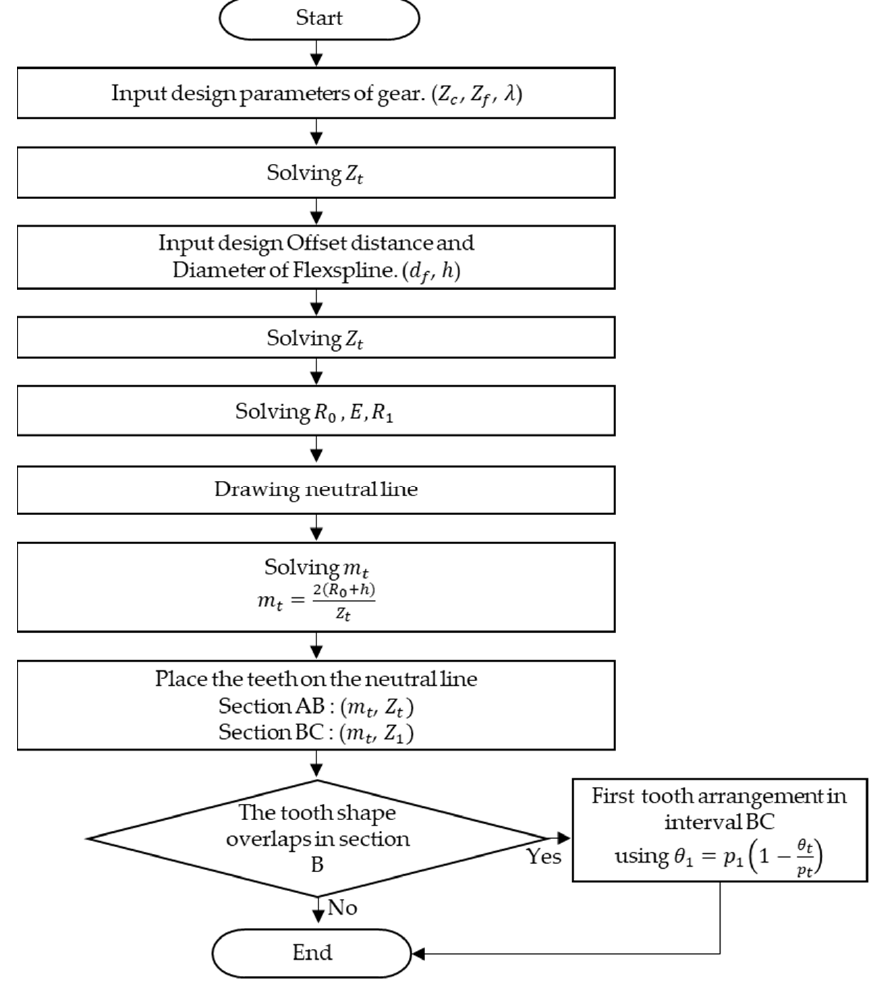
Figure 7. Flowchart for designing a harmonic drive.